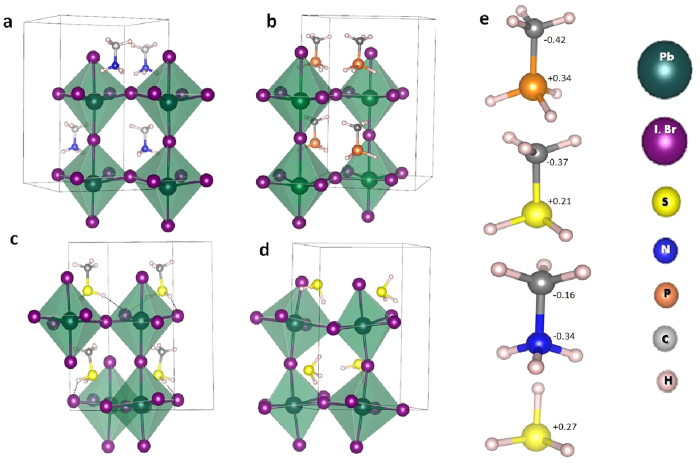
Crystal structures of the tetragonal phases of (a) CH3NH3PbX3, (b) CH3PH3PbX3, (c) CH3SH2PbX3, and (d) SH3PbX3 where X = I or Br. (e) The partial charges of the used cations3637.